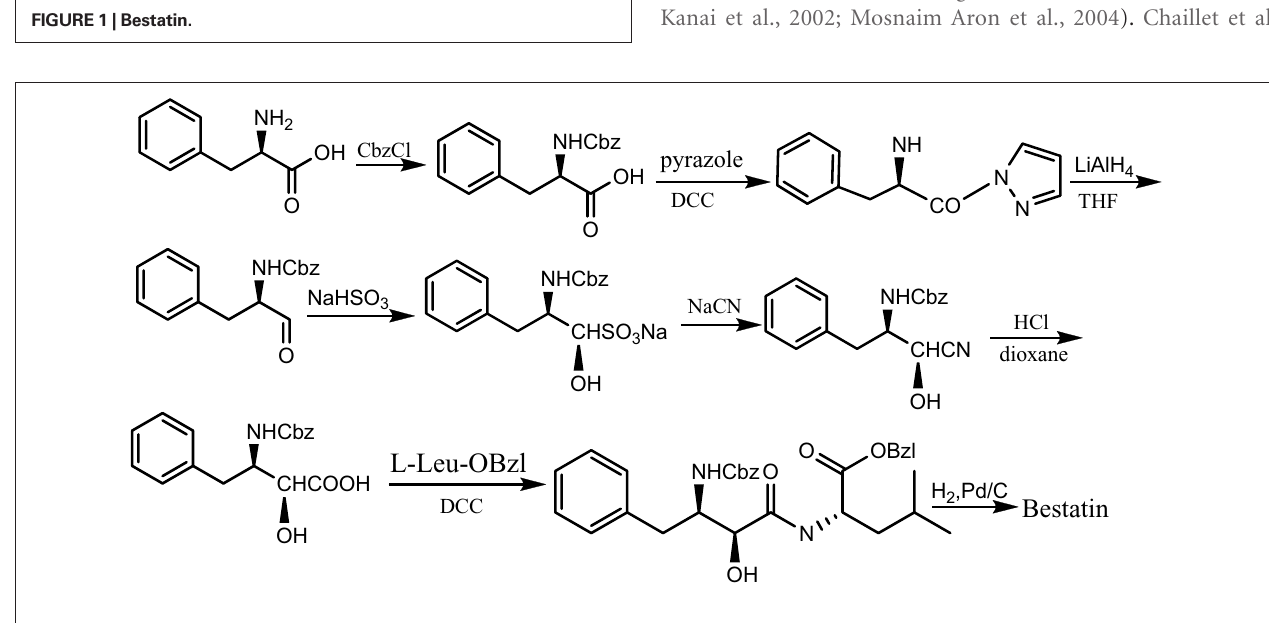
Figure 2 | The synthetic route of